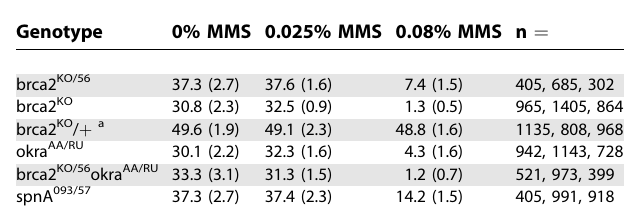
Table 1. Irradiation Sensitivity of brca2 Mutants Genotype